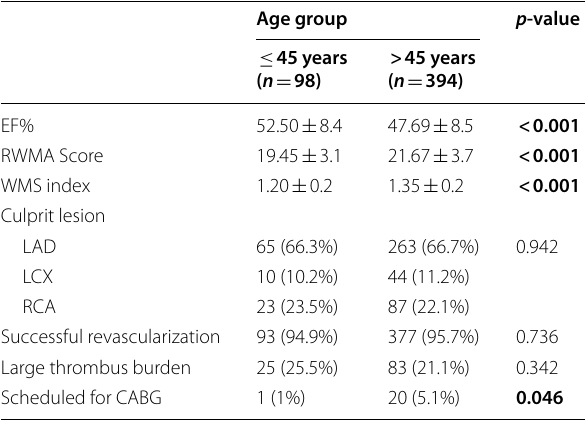
Table 2 Baseline echocardiographic and interventional data